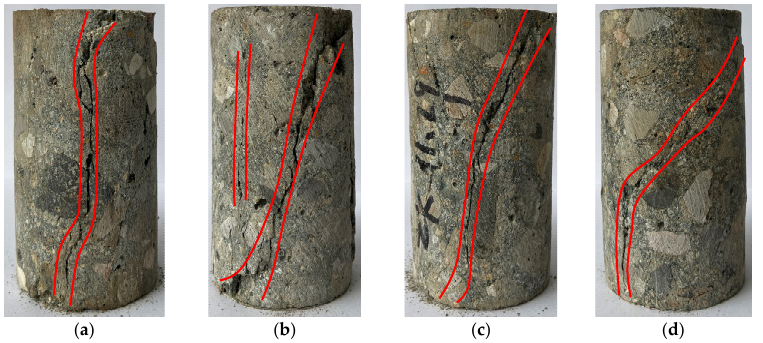
Figure 4. Failure modes of RAC8009 under different confining pressures. ( a ) σ 3 = 0 MPa, ( b ) σ 3 = 2.5 MPa, ( c ) σ 3 = 5 MPa, ( d ) σ 3 = 5 MPa.